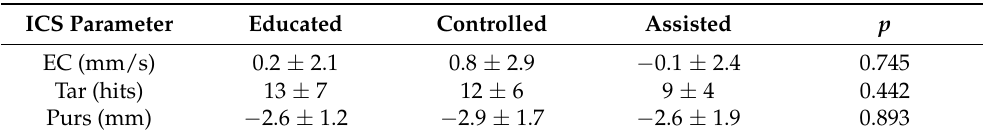
Table 2. Comparison of the communication